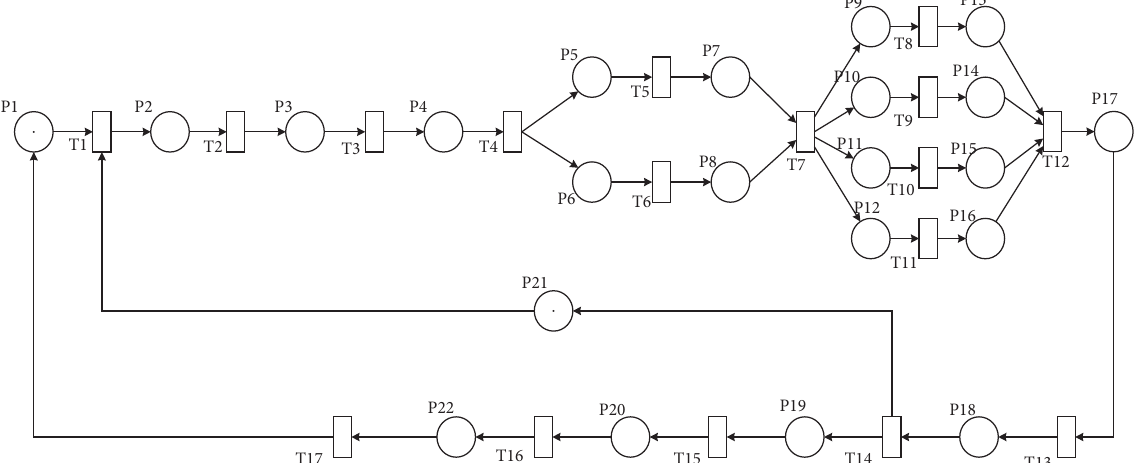
Figure 2: SPN model of postdisaster aviation medical rescue